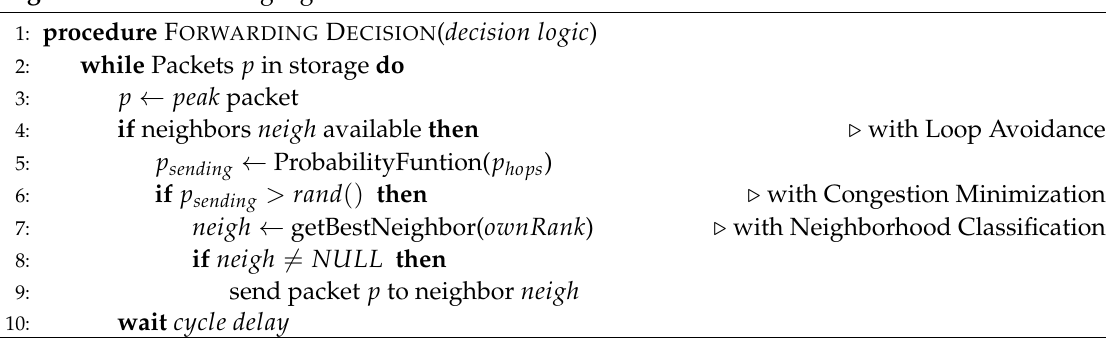
Algorithm 1 Forwarding